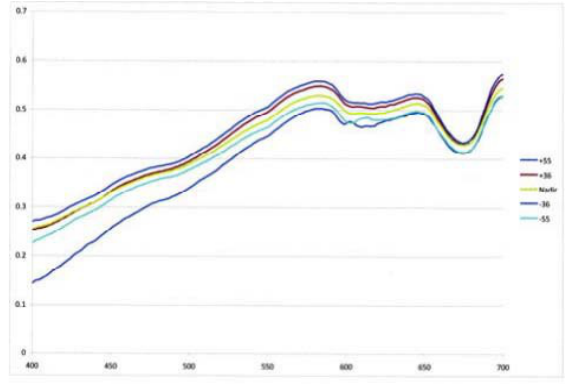
Figure 6: Reflectance of benthic microalgae in the solar principal plane for five view angles.